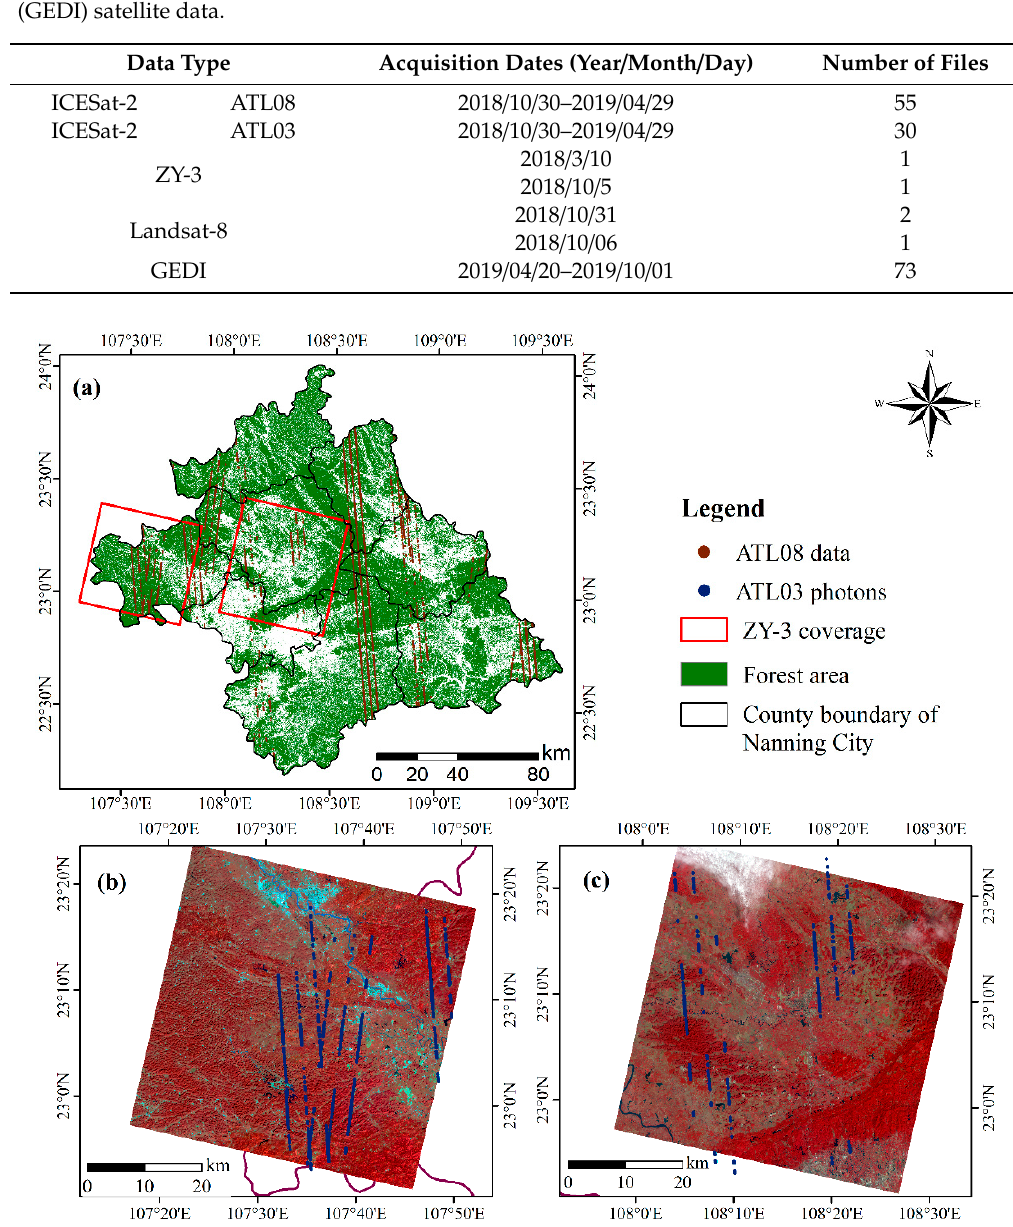
Figure 2. ICESat-2 ATLAS ground tracks within the city of Nanning (a shows the distribution of ATL08 data in the study area, b and c show the distribution of ATL03 photons and ZY-3).